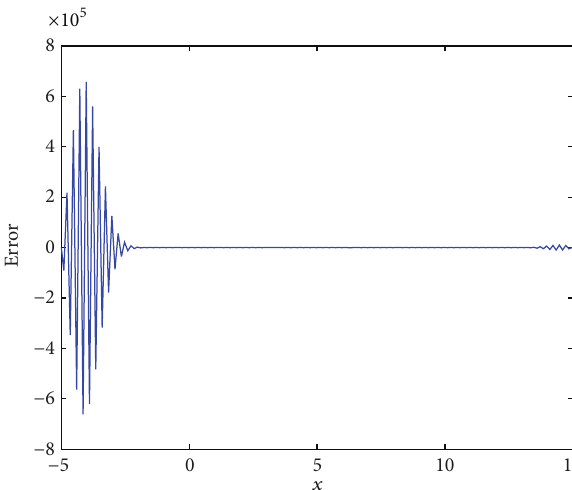
Figure 1: Numerical solutions of (1) by means of the FWA method for 𝜆 = 0.9 , Δ𝑥 = 1/40 , and 𝑆 = 1.2 . The numerical solutions are shown after 100 (dots), 1000 (stars), and 4000 (circles) time steps. The lines correspond to the exact solutions.